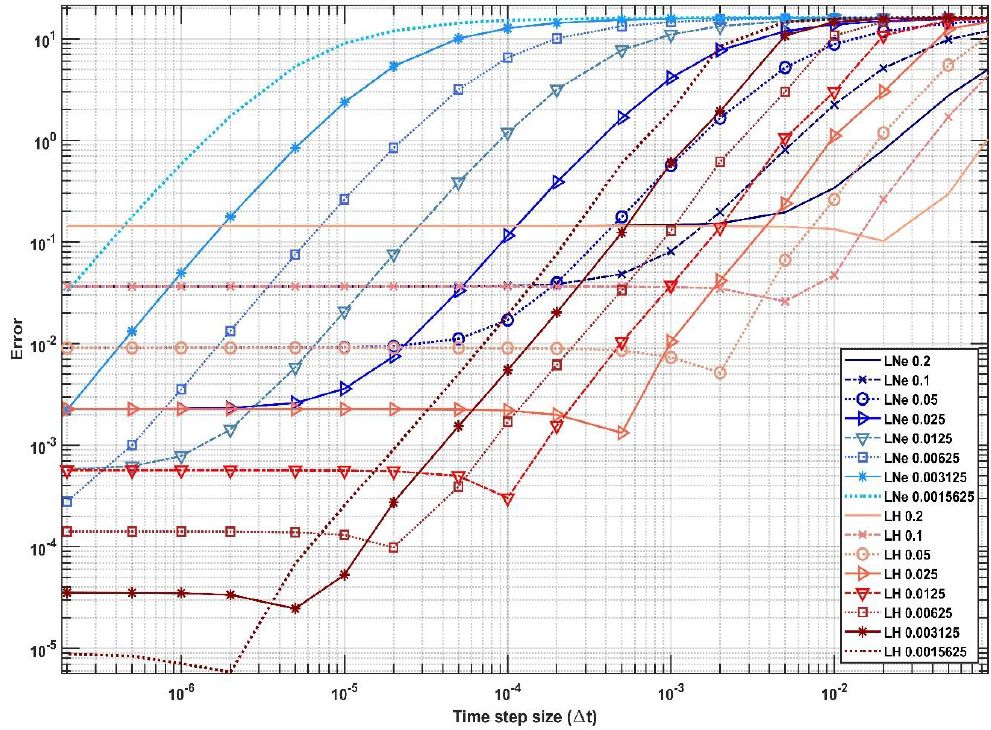
Figure 9. Errors as a function of the time step size for the LNe and the LH methods with different space step sizes in Experiment 3.